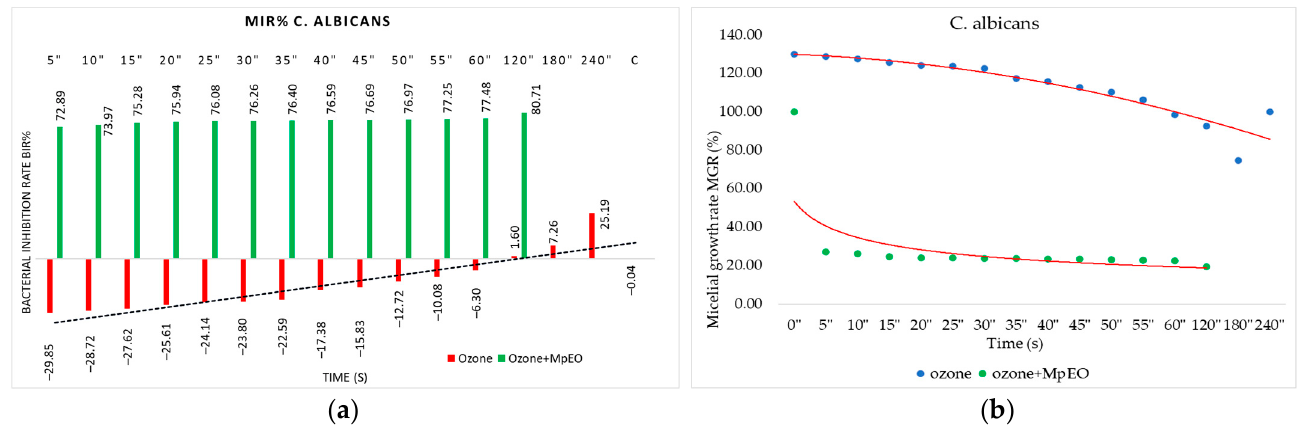
Figure 5. Ozone and ozone+MpEO antimicrobial activity on E. coli at different time exposures expressed in seconds ( ″ ). ( a ) Results expressed as BIR%; ( b ) results expressed as BGR%.